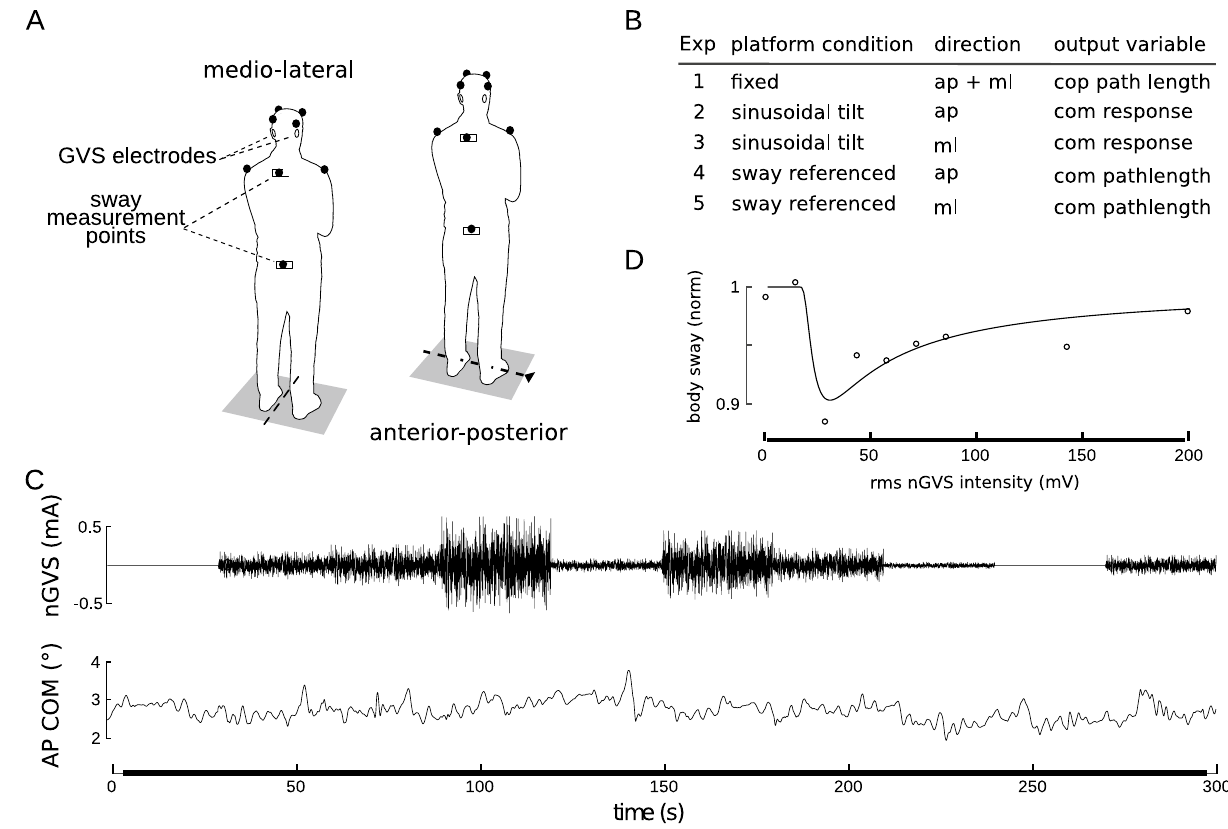
Figure 1. Summary of the experimental setup. ( A ) the two stance positions on the tilt platform and marker placements. ( B ) list of experimental conditions. ( C ) example of the nGVS signal and anterior–posterior COM body sway during quiet stance. The order of nGVS amplitudes was randomized for each subject. ( D ) exemplary modulation of body sway across the tested nGVS intensities (simulated data) that follows a SR-like pseudo-bell- shaped curve with corresponding curve fit 4,18